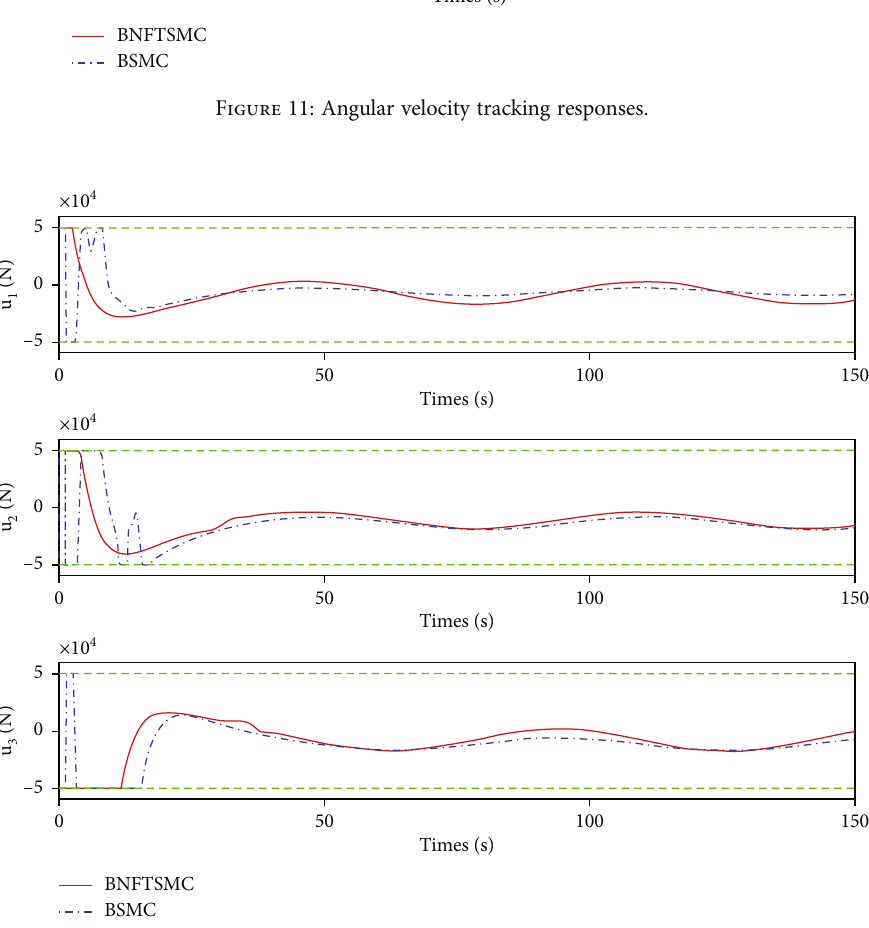
Figure 12: Force